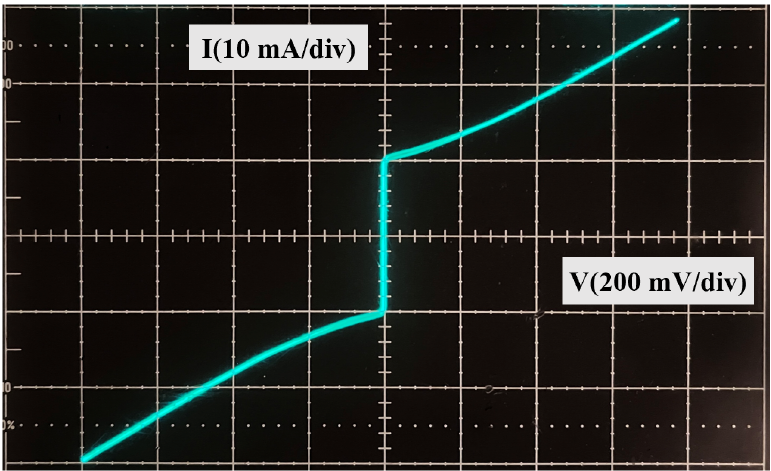
Figure 13. I-V characteristic curve after